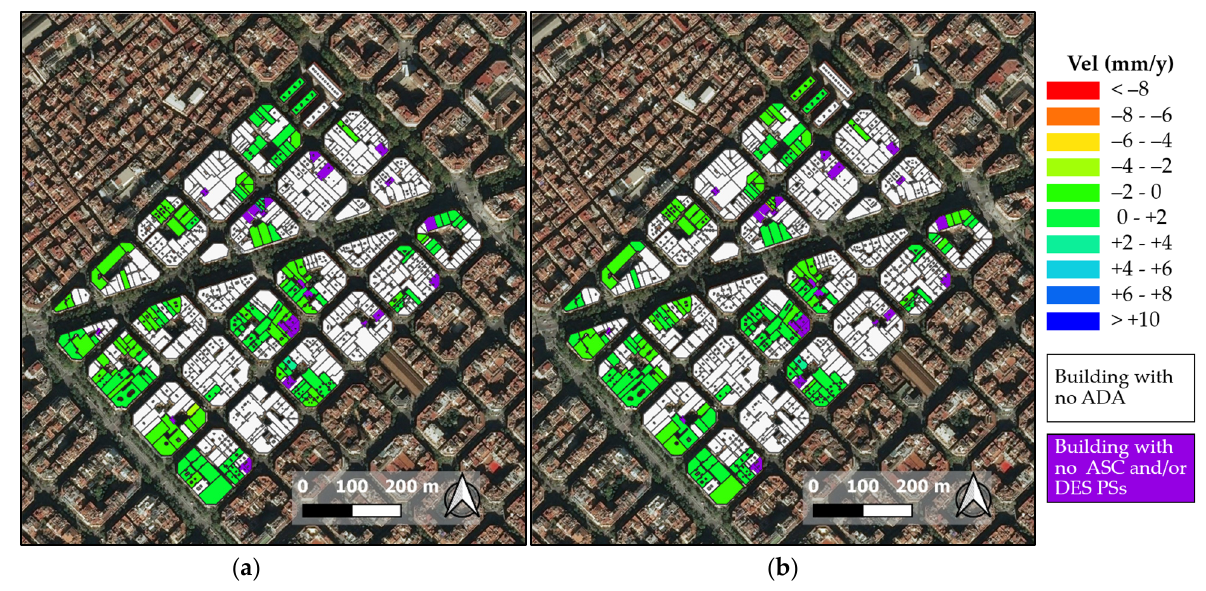
Figure 7. Maps of buildings in Zona Franca area with an average value of mean deformation velocity along ( a ) ascending and ( b ) descending orbit. The violet polygons represent buildings with lack of PSs.